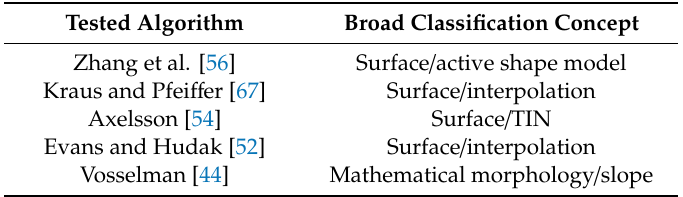
Table 2. A broad description of the ground point identification concepts used by each of the tested